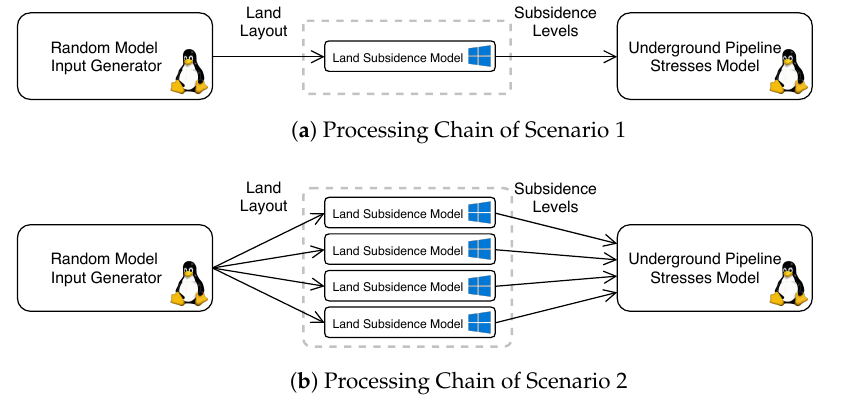
Figure 4. Processing chains of the test scenarios; Scenario 3 is a composition and acts as Scenario 1